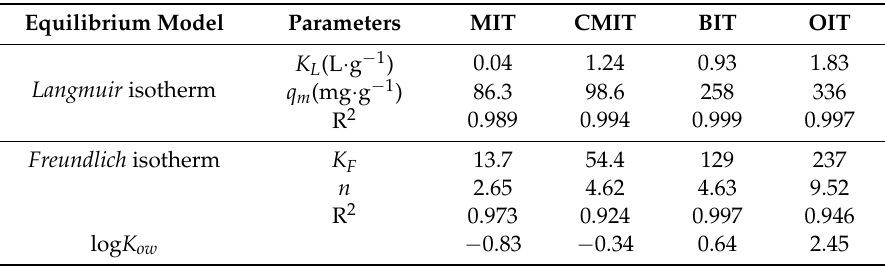
Table 2. Parameters calculated from isotherm models.